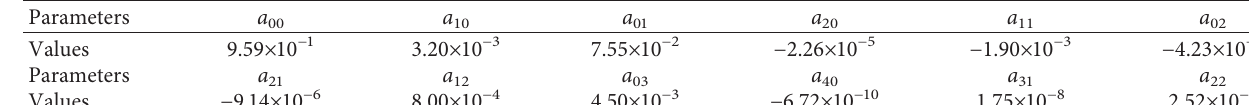
Table 5: The parameters of n .